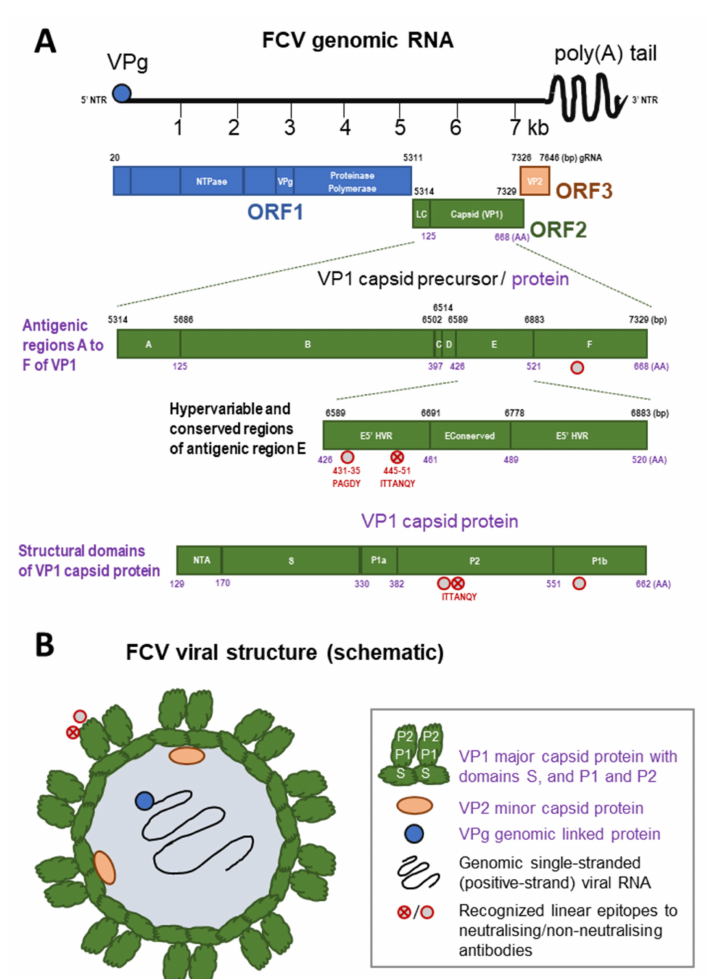
Figure 2. ( A ) Genomic organisation of FCV genomic RNA with open reading frames (ORF) 1 to 3, antigenic regions (A to F) of the VP1 capsid precursor protein, hypervariable and conserved regions of antigenic region E and scheme of the structural domains of the capsid protein VP1 (N-terminal arm [NTA], shell [S], and protruding domain P with subdomains P1 and P2). ( B ) Schematic representation of the viral structure of FCV. Linear non-neutralising epitopes were recognised in the capsid region F and in a conserved area of E5 (cid:48) HVR; moreover, linear epitopes to neutralising antibodies were recognised in E5 (cid:48) HVR [16–18] (indicated by red circles; see figure legend). VPg = virus protein, genome linked. NTR = non-translated region. NTPas = nucleoside-triphosphatase. LC = capsid leader. HVR = hypervariable region. Not drawn to scale. Combined and adapted from